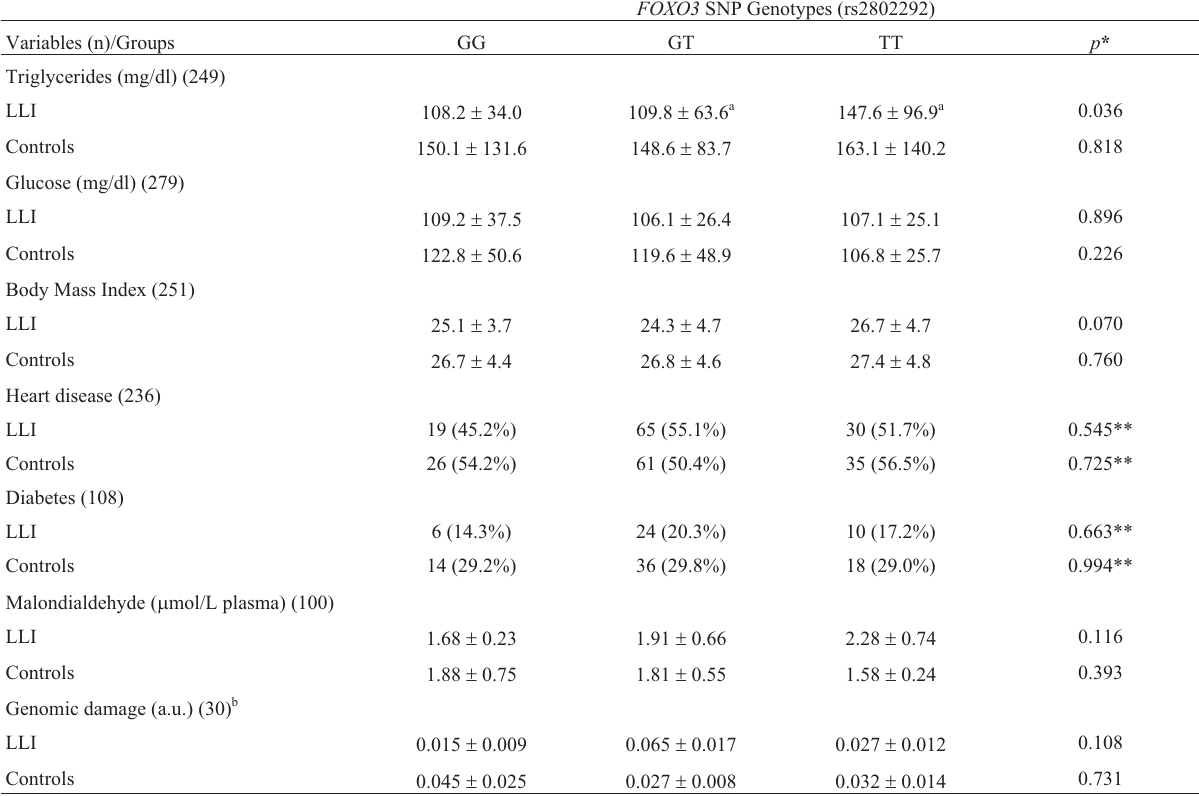
FOXO3 SNP Genotypes